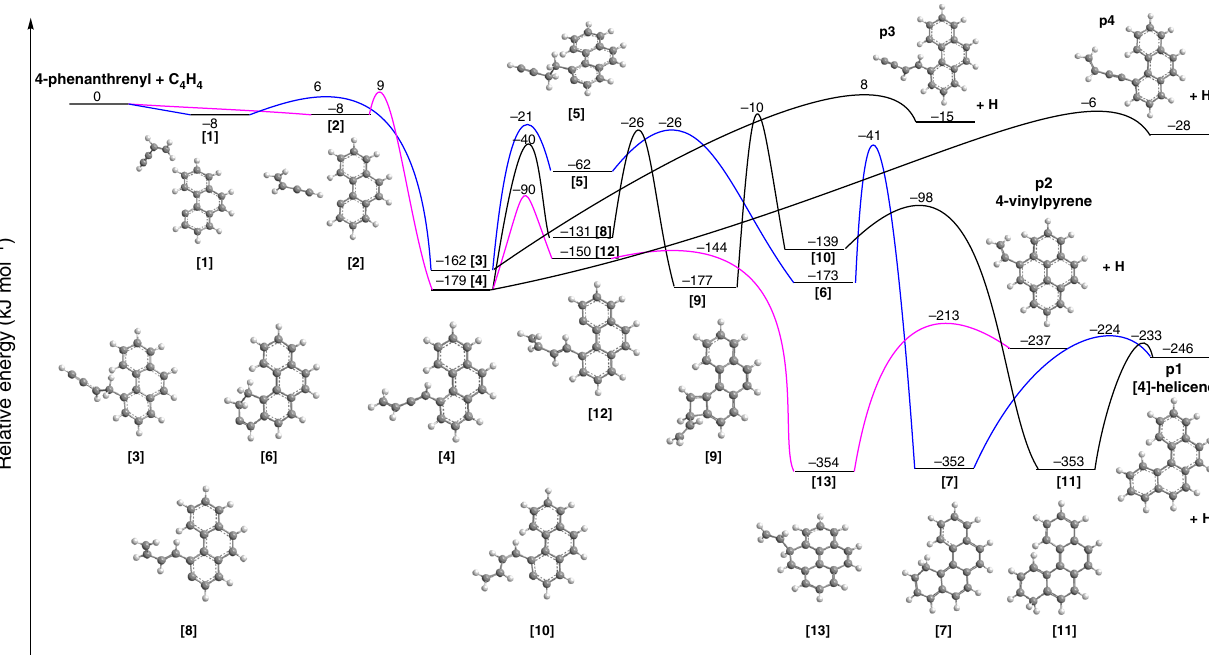
Fig. 4 Potential energy surface (PES) for the 4-phenanthrenyl [C 14 H 9 ] (cid:129) reaction with vinylacetylene (C 4 H 4 ). This PES was calculated at the G3(MP2,CC)// B3LYP/6-311G(d,p) level of theory for the channels leading to [4]-helicene p1 , 4-vinylpyrene p2 , 4-(( E )-but-1-en-3-yn-1-yl)phenanthrene p3 , and 4-(but-3- en-1-yn-1-yl)phenanthrene p4 . The relative energies are given in kJ mol –